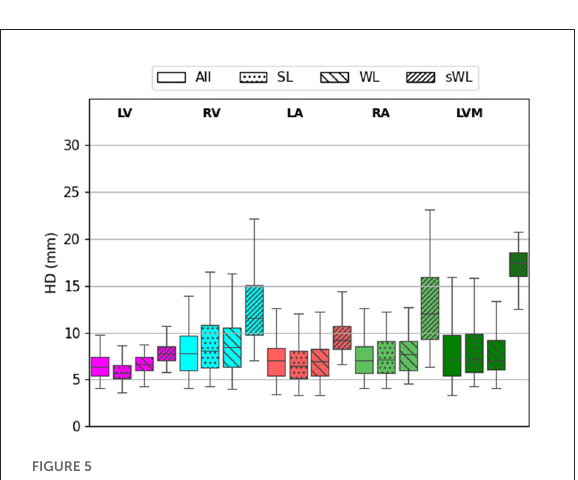
FIGURE5 Hausdorff distance (HD) calculated from the testing of 60 independent cardiac CTA studies comparing the four trained models based on the All, strong label (SL), weak label (WL), and synthetic weak label (sWL) dataset. Average HD is reported in mm for each structure including left and right ventricles (LV, RV), left and right atria (LA, RA), and LV myocardium